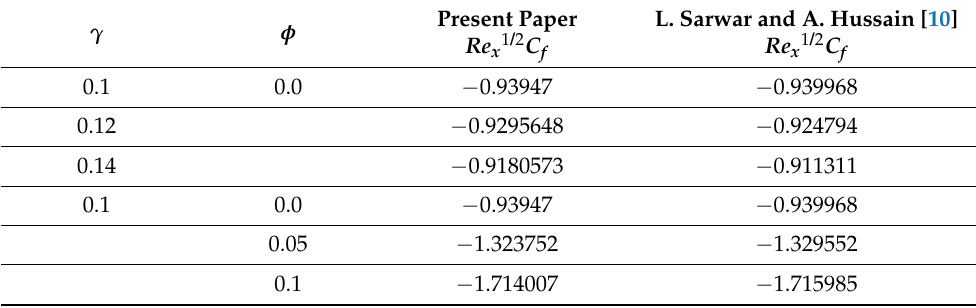
Table 4. Comparisons with a previous study, when S = 0, β =